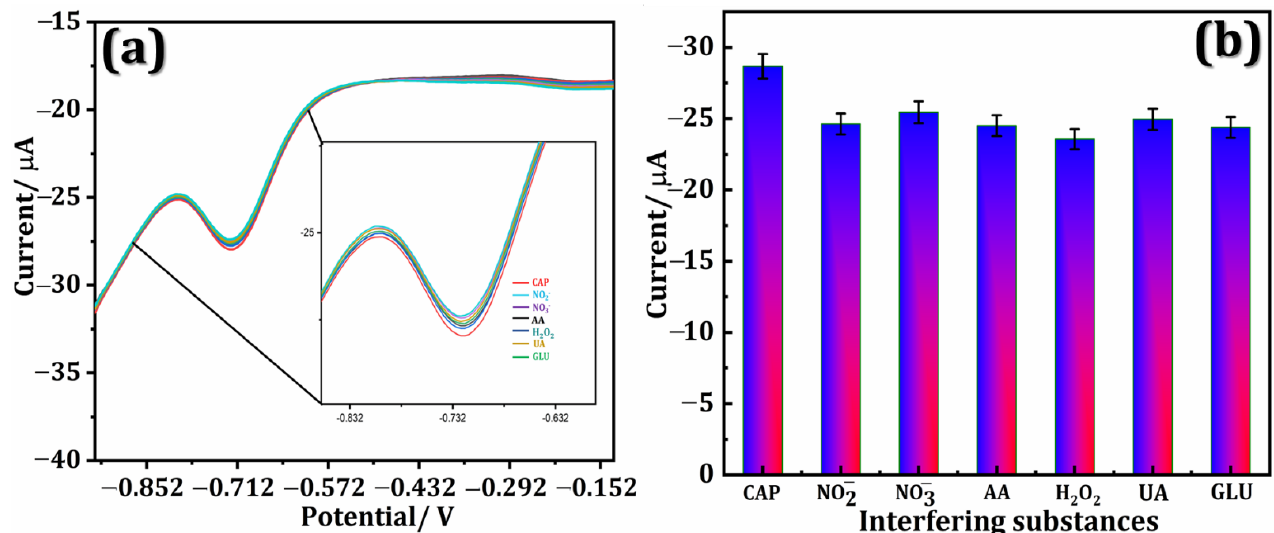
Figure 6. ( a ) DPV curves for the Sr@Se/PGCN/GCE in the presence of CAP and CAP with different interfering substances, and ( b ) Bar graph of different interfering substances versus I pc .